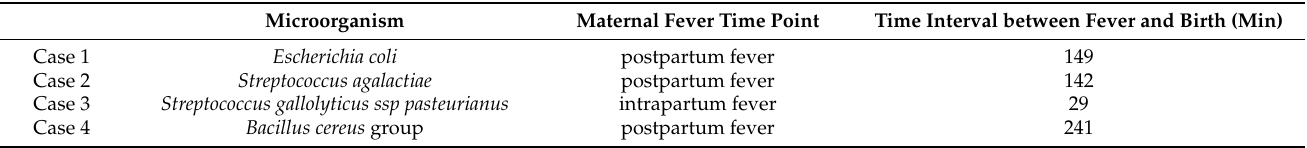
Table 2. Maternal fever time point and